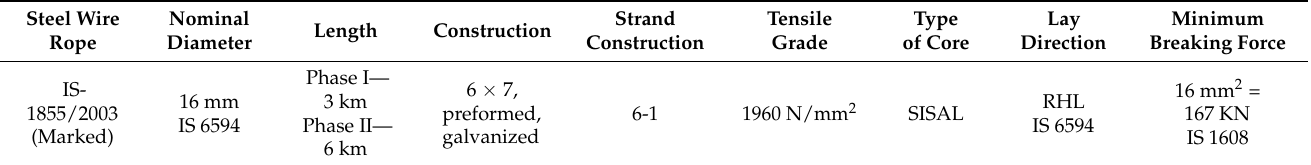
Table 6. Steel Wire Rope